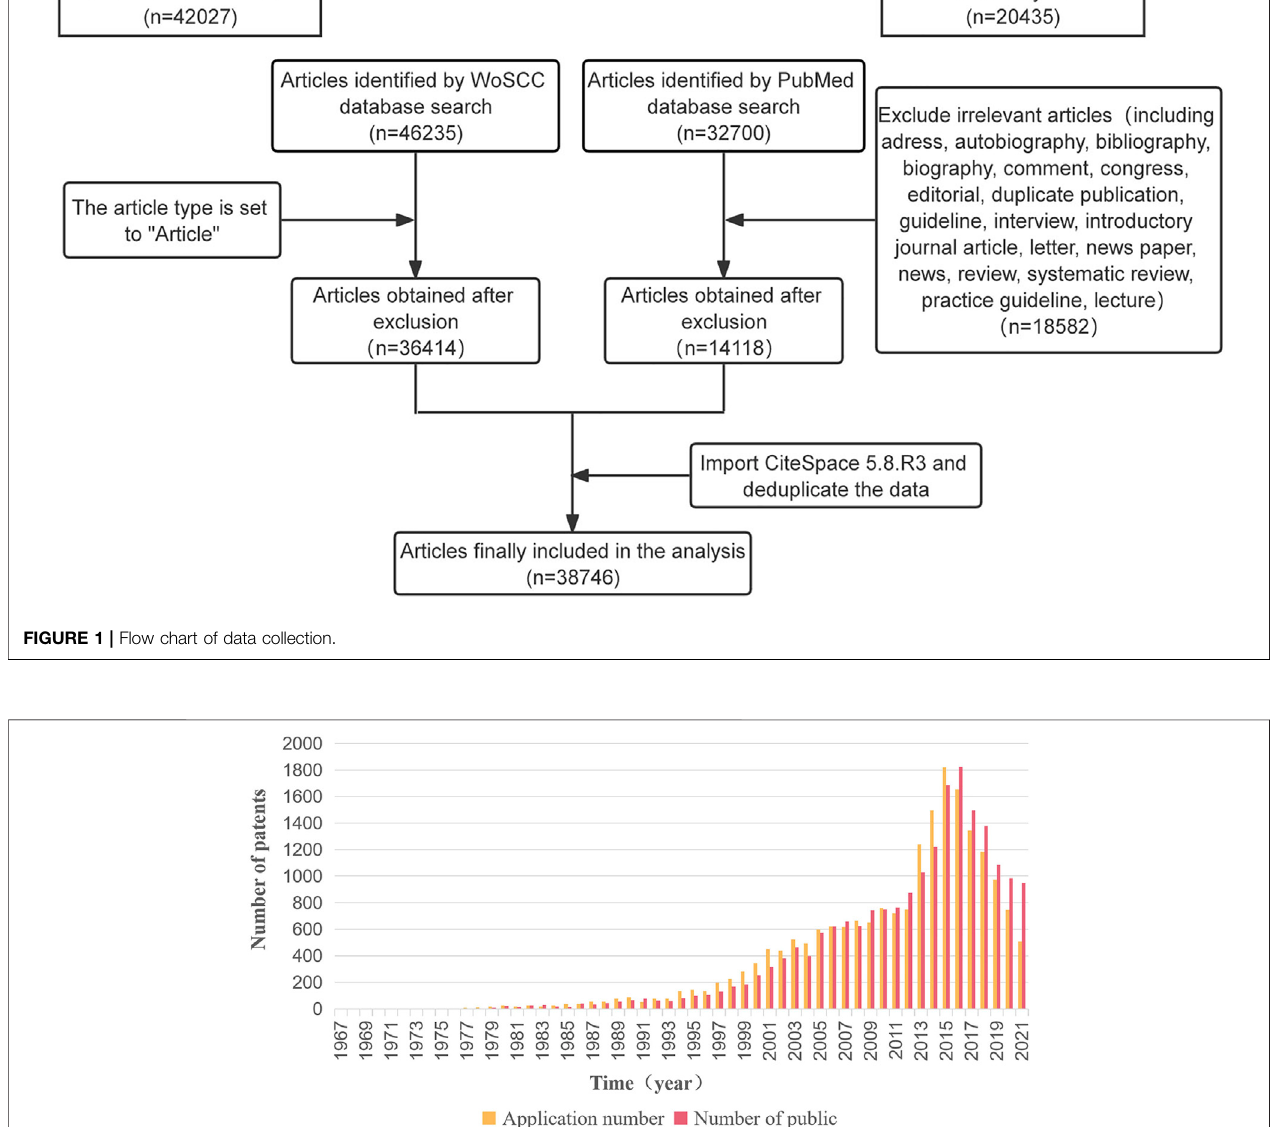
Frontiers in Pharmacology |